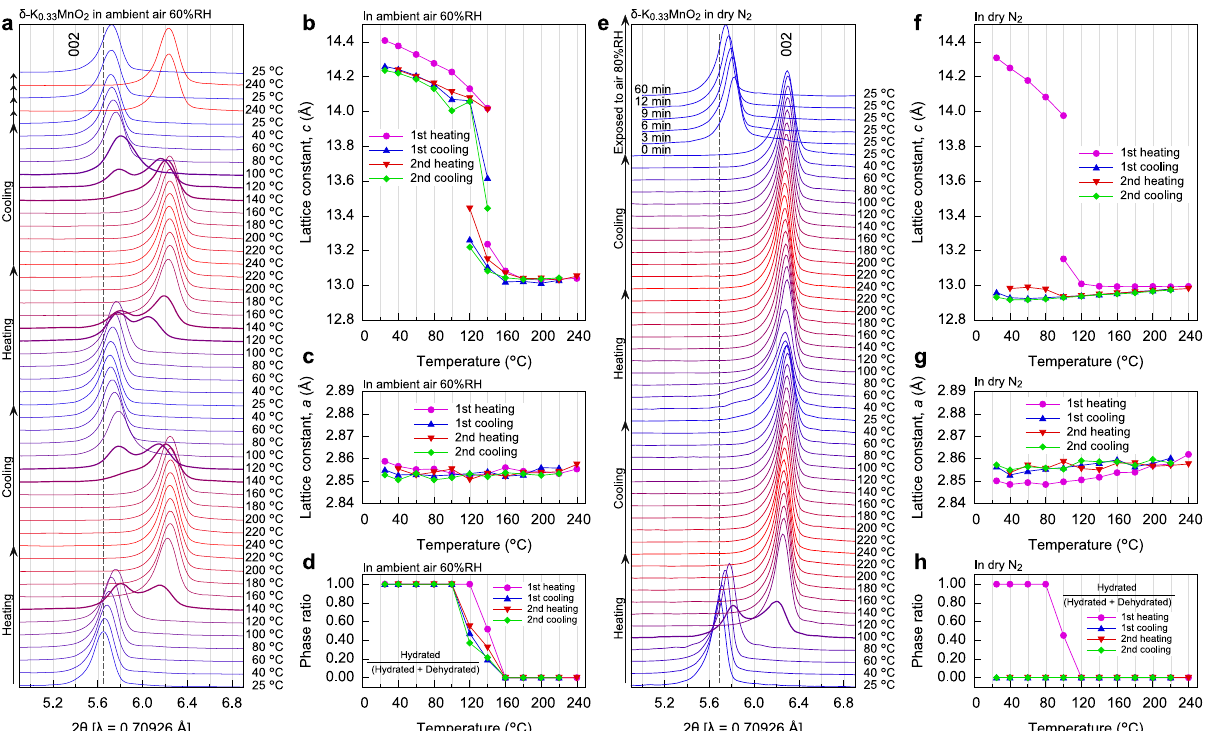
Fig. 2 Structure changes accompanied by dehydration and hydration cycles. a In situ X-ray diffraction (XRD) pro fi les for δ -K 0.33 MnO 2 in an ambient atmosphere (60%RH at 24 °C) for thermal cycle processes between 25 and 240 °C. b , c Lattice constants c ( b ), and a ( c ) determined from the XRD pro fi les. d Fraction of hydrated phase obtained from the XRD intensities of the hydrated and dehydrated phases. e – h In situ X-ray diffraction pro fi les ( e ), the lattice constants c ( f ), and a ( g ), and the phase fraction ( h ) measured under a dry N 2 -gas fl ow without moisture. In ( e ), the sample was exposed to an ambient air of 80%RH at 24 °C.